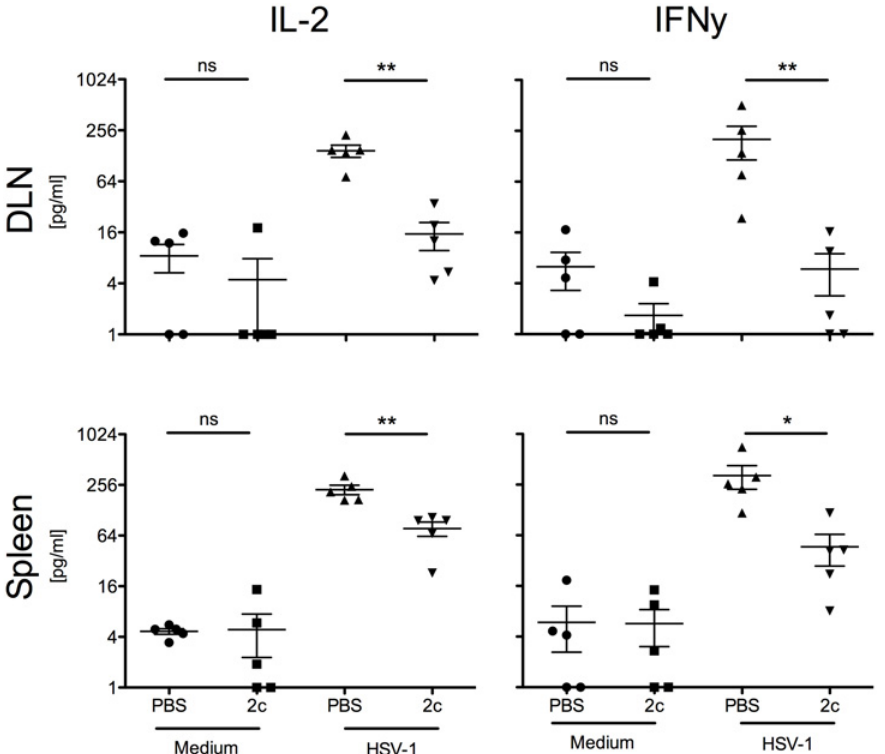
Figure 8. Reduced IL-2 and IFN- γ production by systemic mAb 2c application. BALB/c mice (n = 5) were intravenously injected with 300 µ g mAb 2c before corneal infection with HSV-1 KOS (1x105 PFU/cornea). At day 14 post infection, spleens and draining lymph nodes were isolated and homogenized. Cells were cultivated in triplicates in the presence of 2 × 10 7 PFU UV-inactivated HSV-1 or medium alone for stimulation. After 24 h, the contents of IL-2 and IFN- γ in cell supernatants were quantified by ELISA. Statistical analysis was undertaken with a nonparametric ANOVA test. Comparisons were considered significant at * P < 0.05. Error bars represent the standard error of the